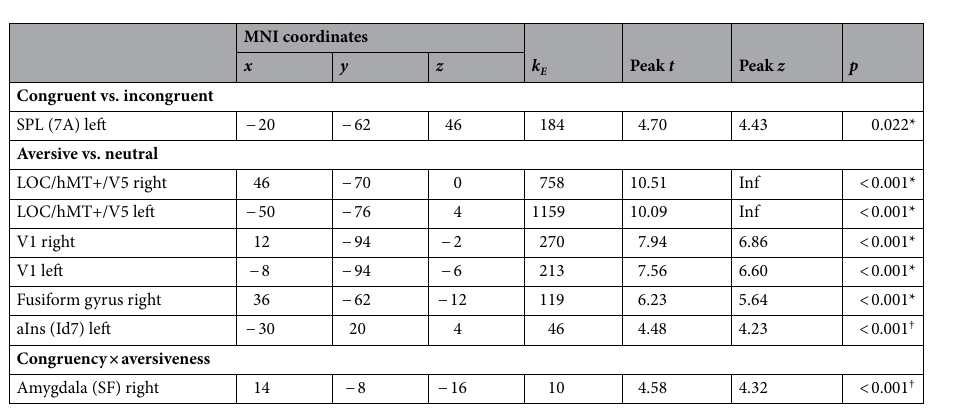
Figure 2. ( a ) Congruent versus incongruent visual-tactile stimulation produced significant activation differences in the left SPL (area 7A; p < 0.05, FWE corrected on the cluster level). ( b ) Aversive versus neutral stimuli showed significant activation differences in left aIns (area Id7; p < 0.001, uncorrected), and left and right middle temporal area (LOC/hMT+/V5), left and right V1, and right fusiform gyrus ( p < 0.05, FWE corrected on the cluster level). ( c ) Interaction congruency × aversiveness revealed activations in right amygdala (area SF; p < 0.001, uncorrected). Here, activations within anatomical masks of the bilateral amygdala and insula (SPM Anatomy Toolbox 41 ) are shown. Mean contrast estimates of peak activations for both regions are plotted; error bars represent standard error.